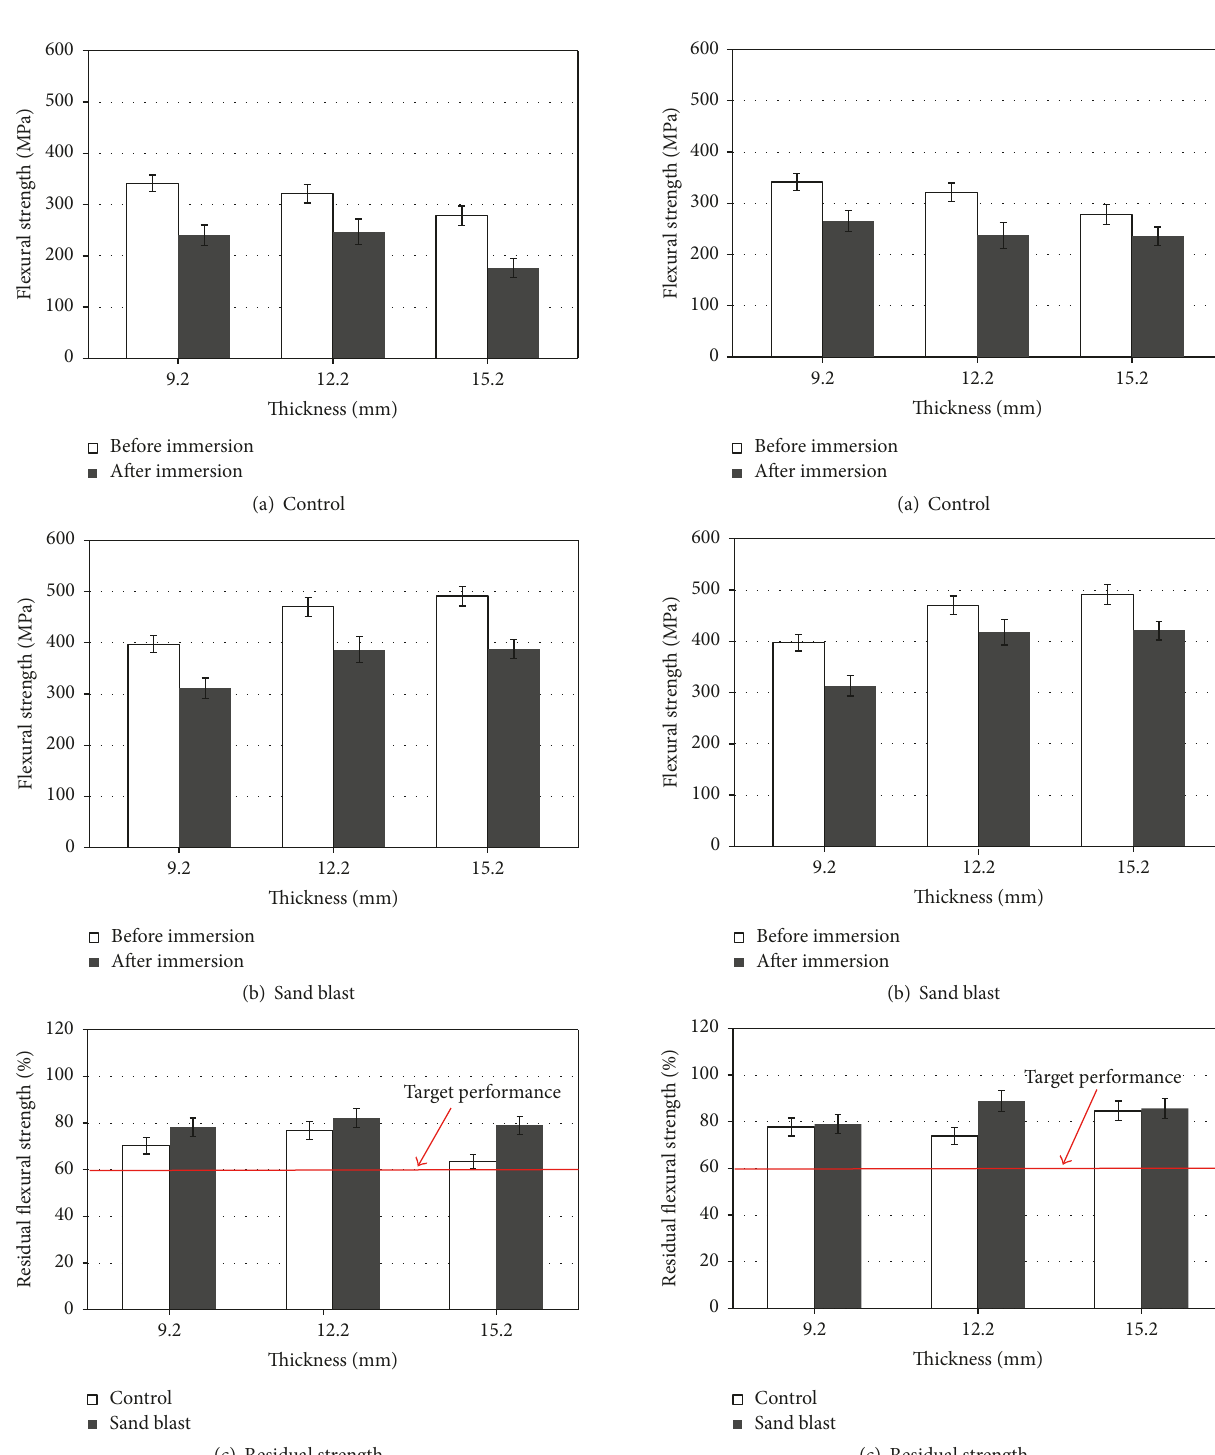
Figure 14: Flexural test results of Na 2 SO 4 solution immersions.